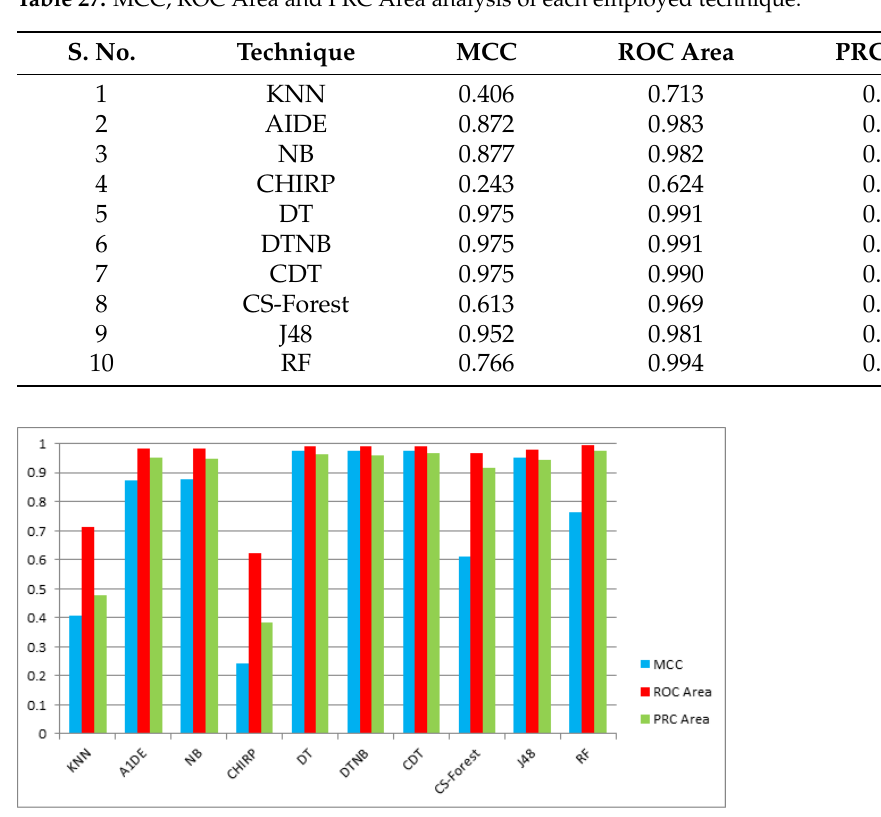
Table 27. MCC, ROC Area and PRC Area analysis of each employed technique.